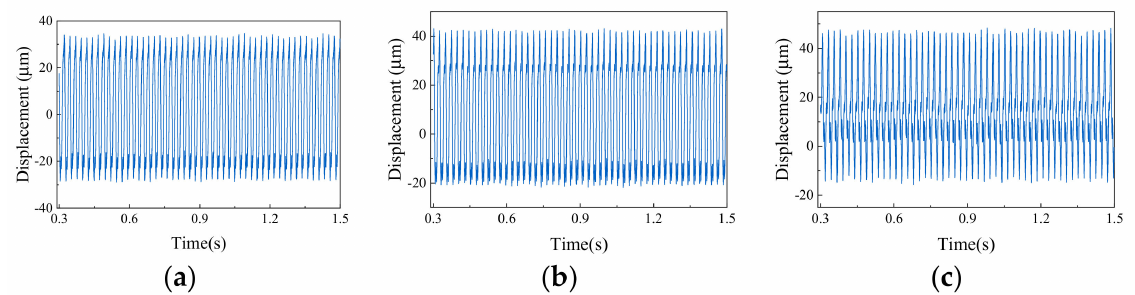
Figure 21. Misaligned faults: ( a ) value of imbalance 2.5 × 10 − 5 kg · m; ( b ) value of imbalance 5 × 10 − 5 kg · m; ( c ) value of imbalance 10 × 10 − 5 kg · m.